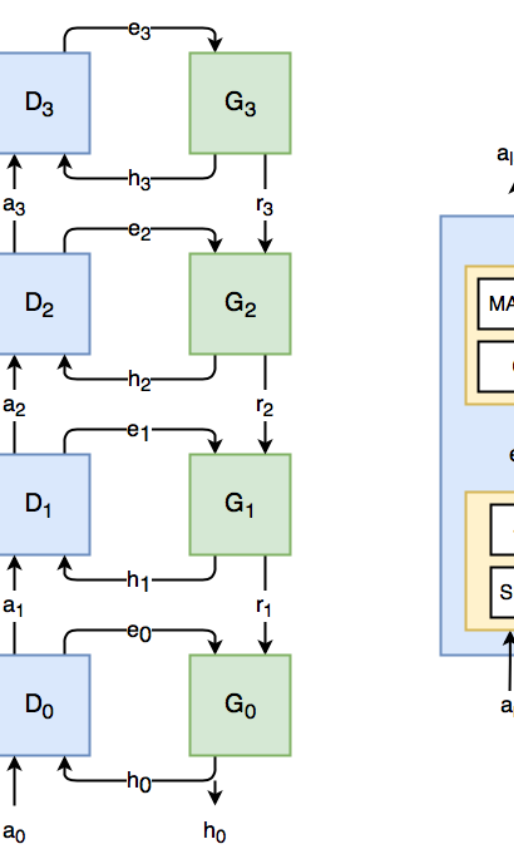
Figure 1. PredNet architecture: in the left the general architecture with the Discriminator blocks and the Generator blocks, in the right details of blocks.